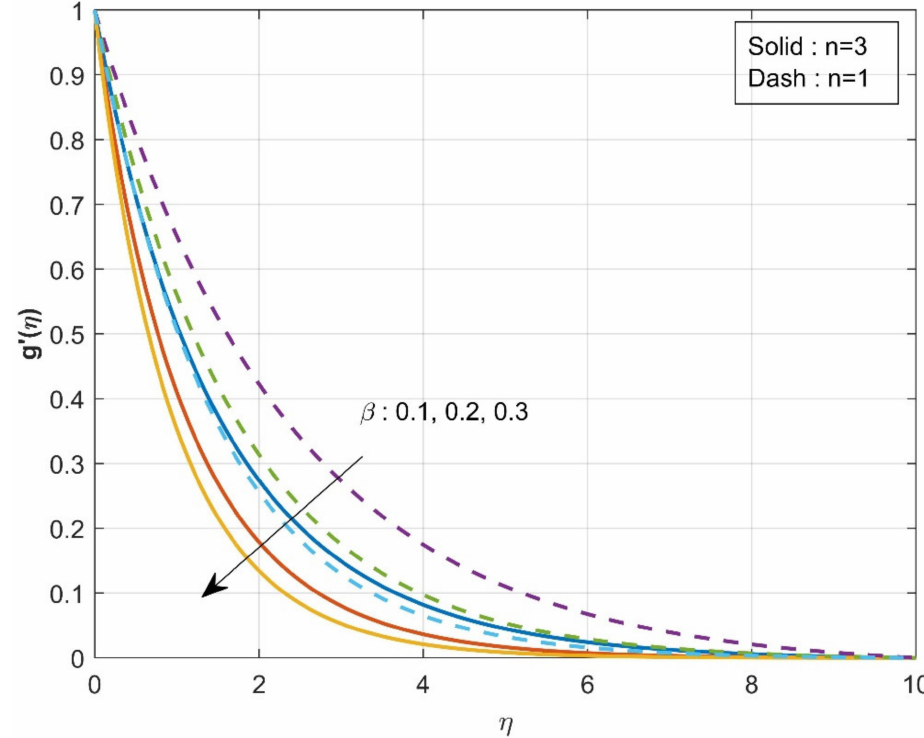
Figure 3. Influence of β over axial velocity g (cid:48) ( η ) .